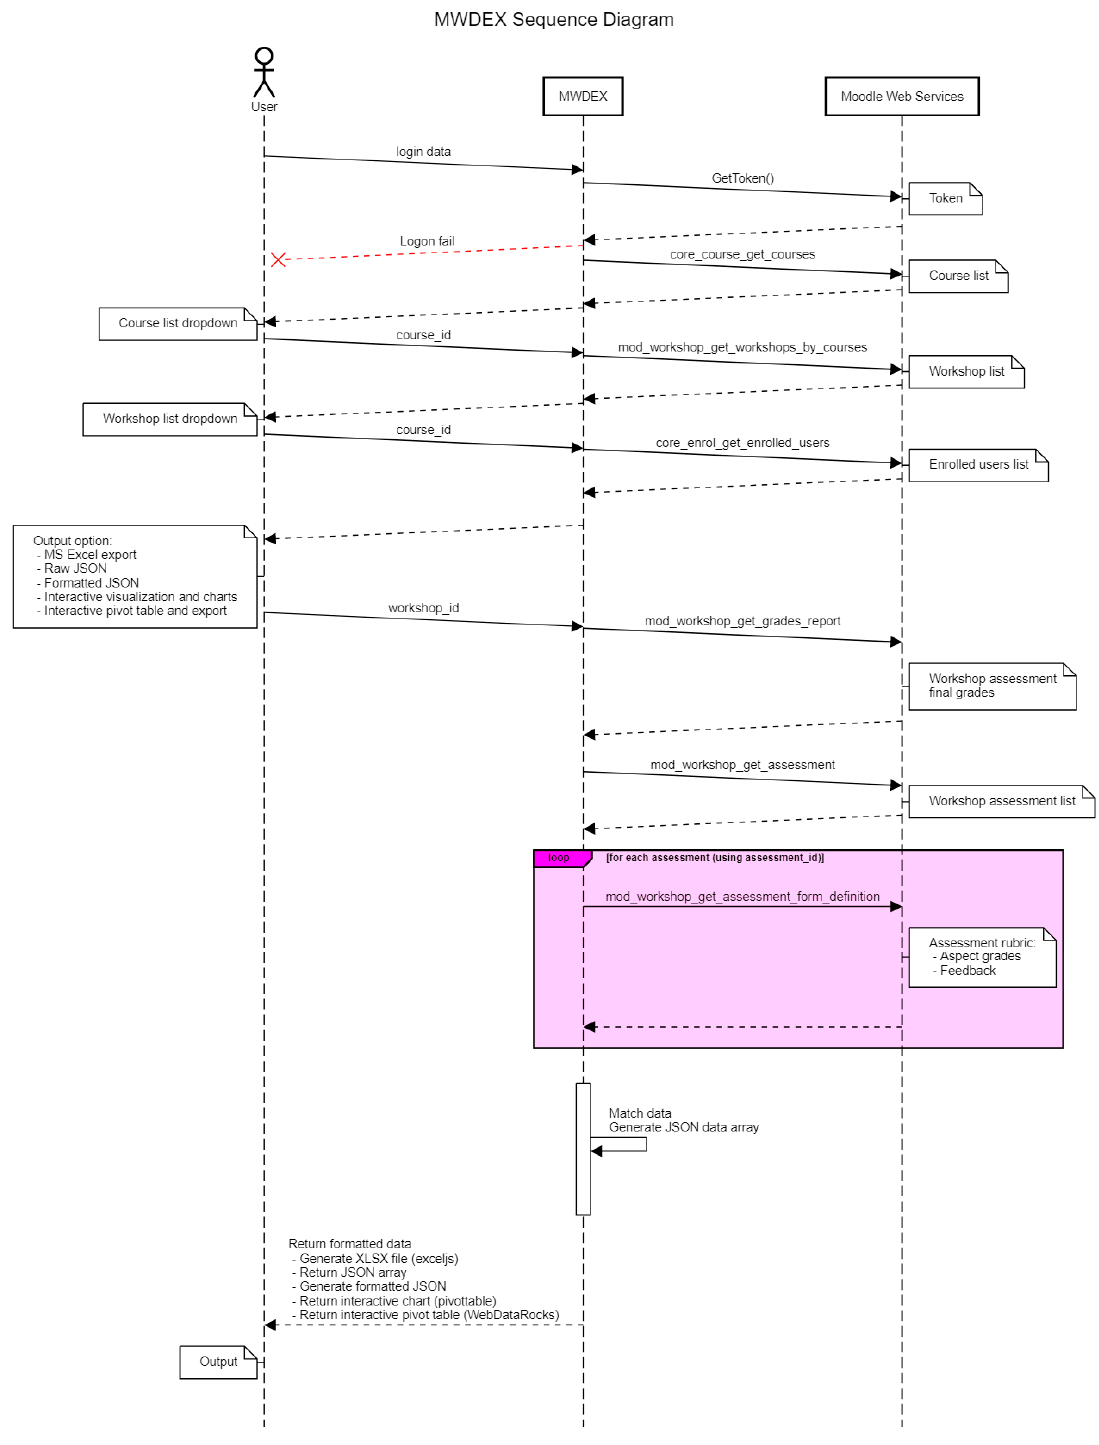
Figure 8. Sequential diagram of the peer assessment data extraction and transformation process of MWDEX.